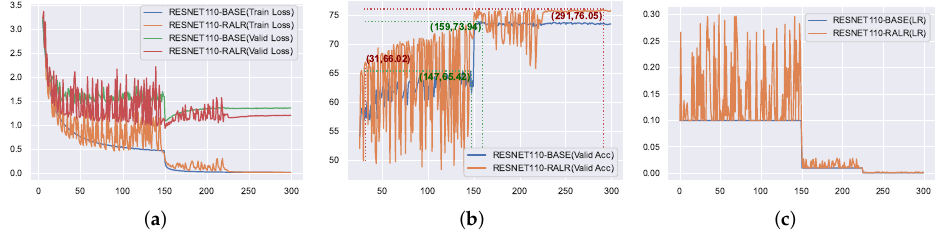
Figure 1. Training and validation loss, validation accuracy, and changing of learning rate while training the CIFAR-100 dataset using network ResNet-110. ( b ) The orange curve shows the validation accuracy of the new learning rate policy. ( a ) Loss. ( b ) Validation accuracy. ( c ) Learning